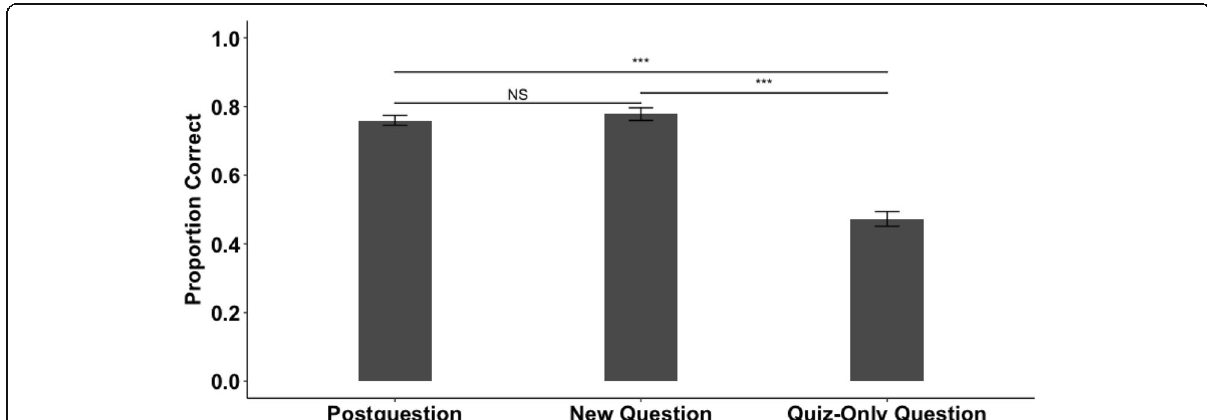
Fig. 4 Proportion correct on weekly quizzes as a function of question type. Postquestion denotes questions asked at the beginning and end of class, New Question denotes questions asked only at the end of class, and Quiz-Only Question denotes never-before-seen questions from the same lessons that only appeared on the weekly quizzes. Error bars represent standard errors. *** p < 0.001; NS not